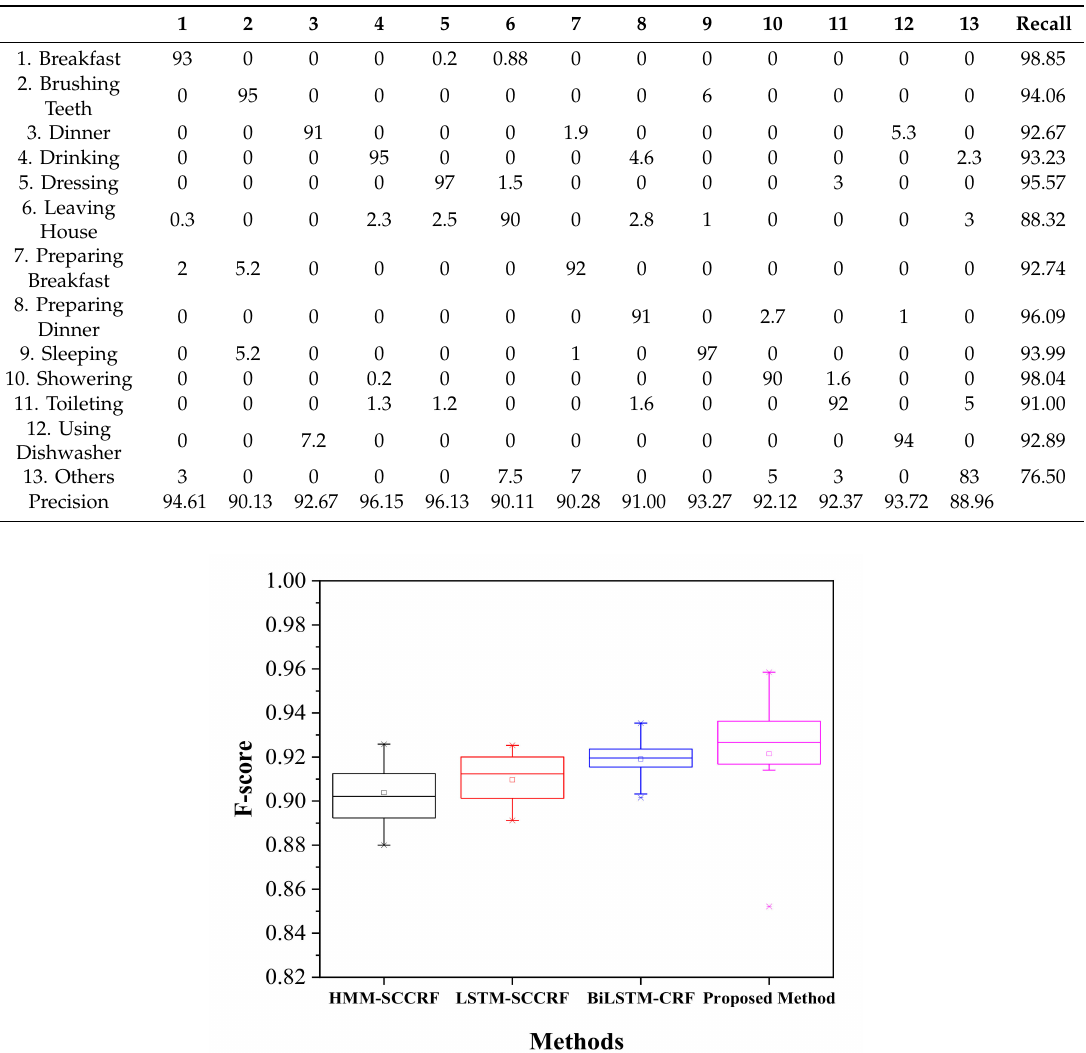
Table 3. Confusion matrix for Kyoto 3.